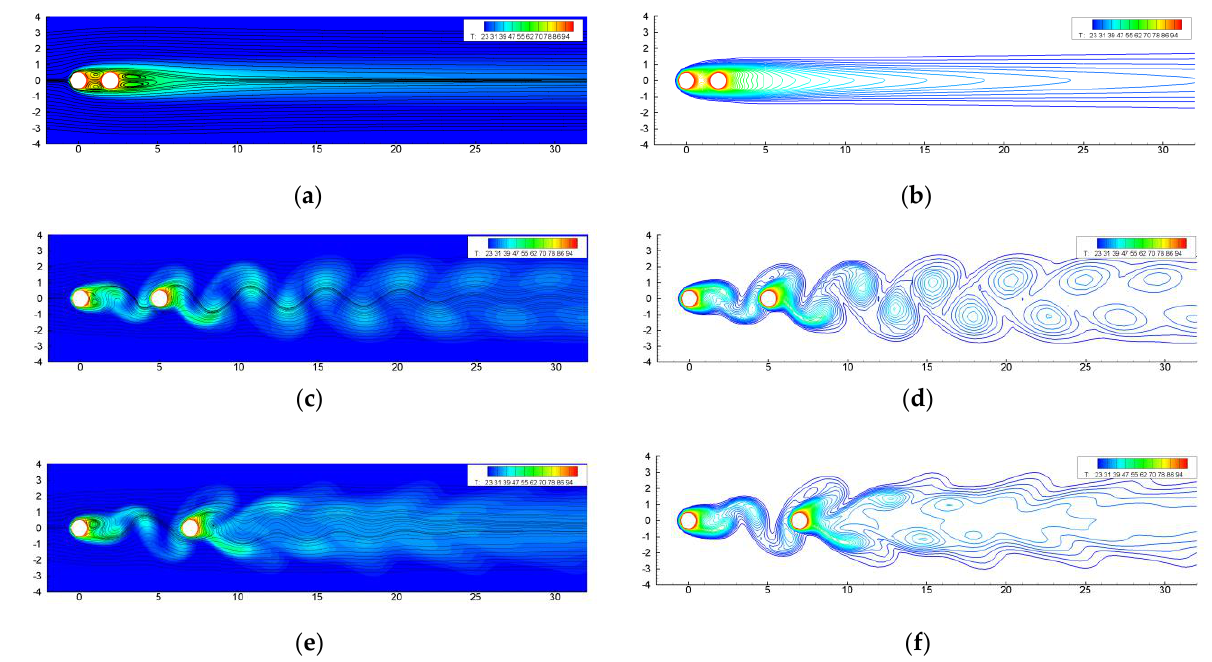
Figure 5. Flow patterns of Re = 100, streamlines (left) and temperature contours (right): ( a , b ) L/D = 2, reattachment; ( c , d ) L/D = 5, co-shedding; ( e , f ) L/D = 7, co-shedding.